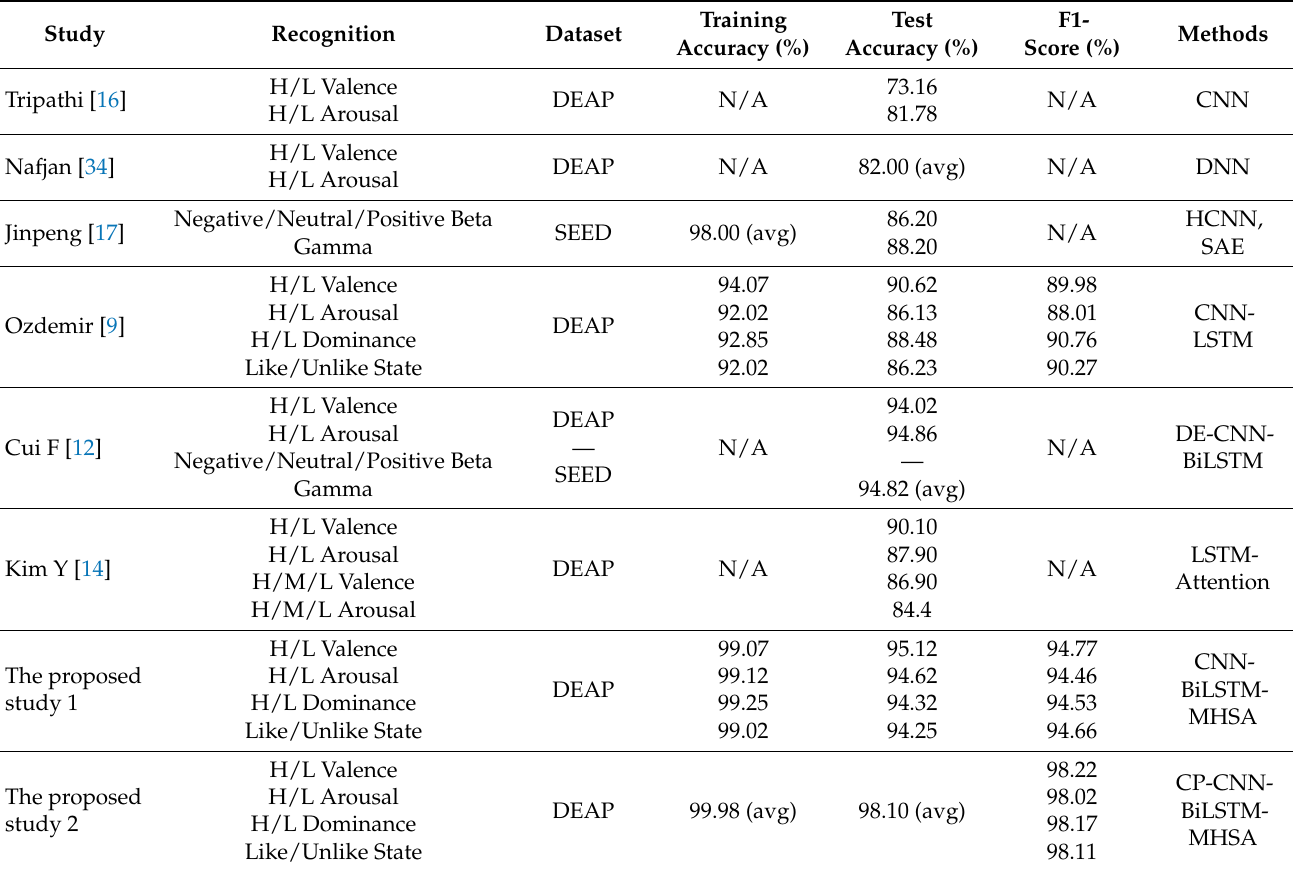
Table 8. Comparison with previous two-classification studies.